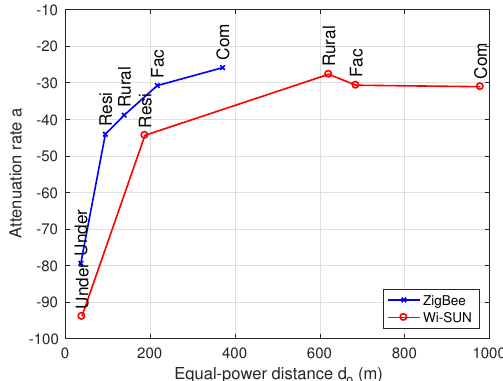
Figure 32. AR with respect to the equal-power distance (EPD) for the five environment areas. The Wi-SUN modem of 920 MHz provides better communication distances for all areas compared to the ZigBee case of 2.4